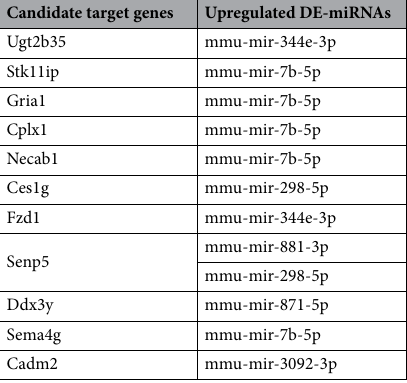
Table 2. Candidate target genes of the upregulated DE-miRNAs.